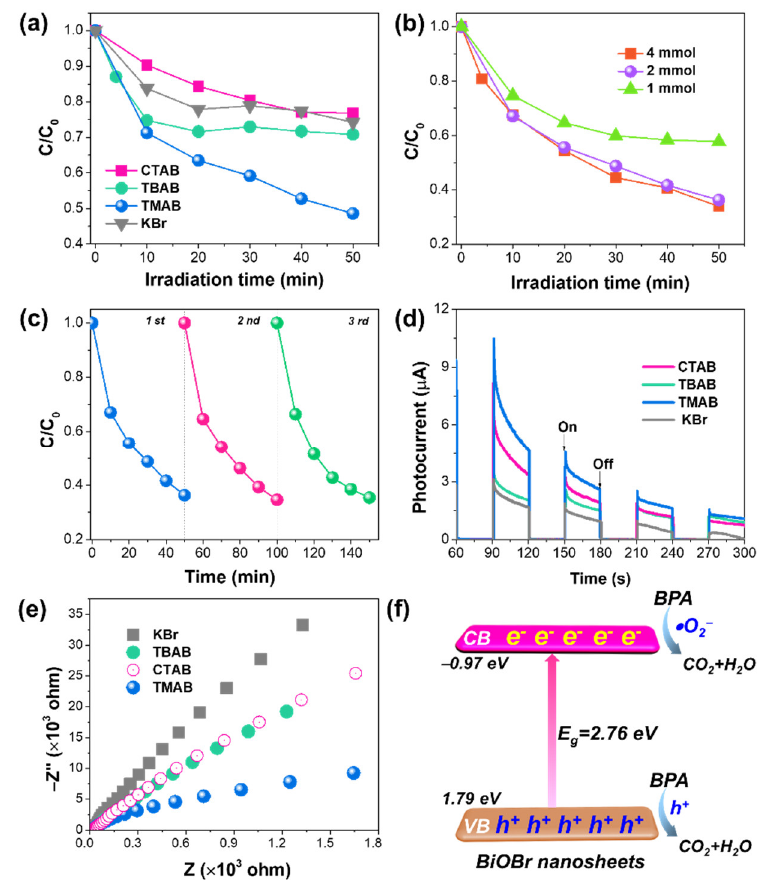
Figure 7. Photocatalytic performances of BPA over the obtained different products ( a ) by altering the bromide sources and ( b ) changing the concentration of the reactants. ( c ) Cycling photocatalytic performances of BiOBr nanosheets obtained in mannitol and in the presence of 2 mmol of TMAB. ( d ) Transient photocurrent density curves and ( e ) EIS spectra of different products. ( f ) Illustration of the photocatalytic process.